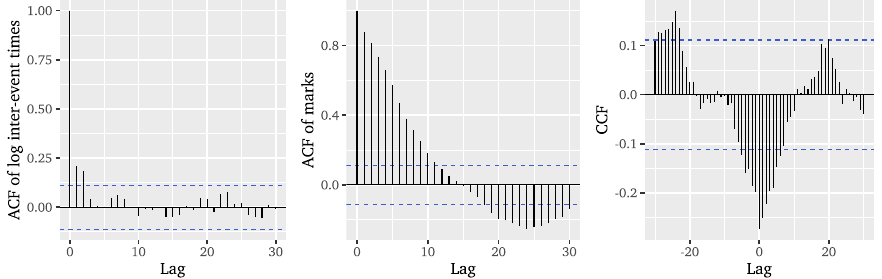
Figure 5. Autocorrelation functions of logarithmic inter–event times, event marks, and their cross- correlation